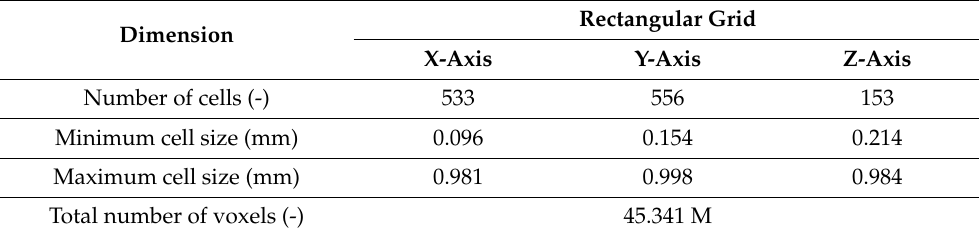
Table 2. Maximum and minimum dimensions of the used rectangular grid.